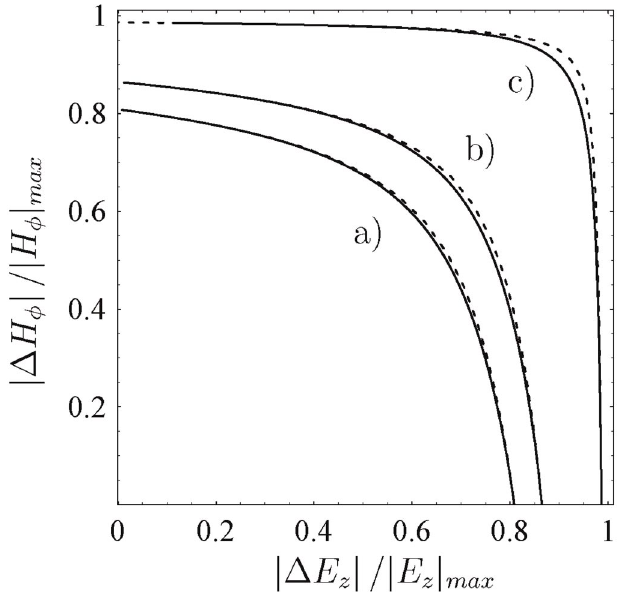
FIG. 5. Normalized variation of the azimuthal magnetic field versus the normalized variation of the longitudinal electric field. The three sets of curves refer to different conductivity jumps: for (cid:1) 0 : 68 , for ( b ) Y (cid:1) 0 : 76 while for ( c ) =Y =Y the curves ( a ) Y n n 0 0